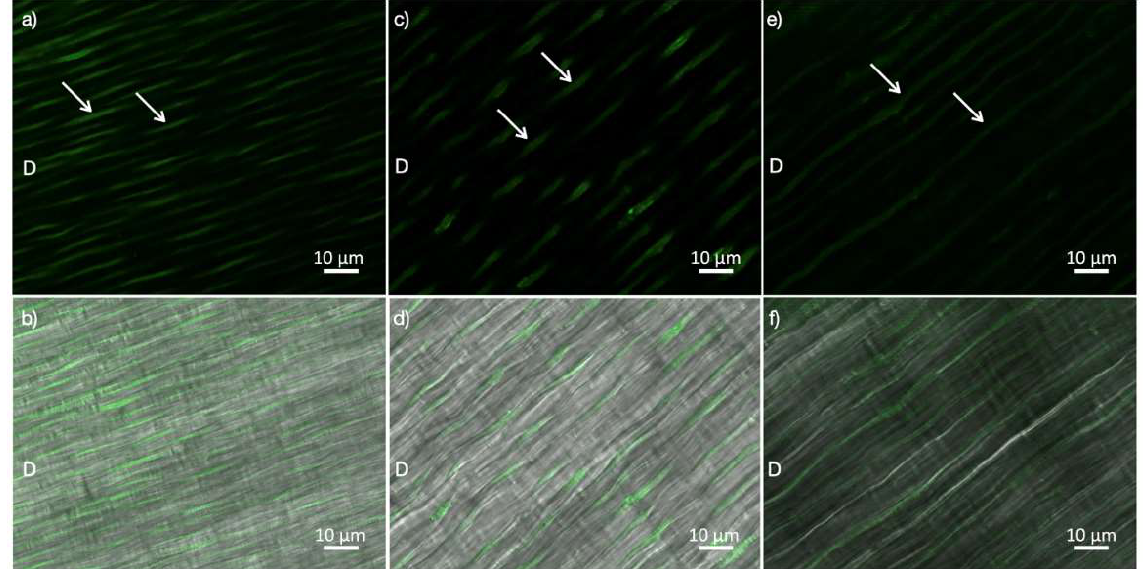
Figure 2. Dentin slices derived from all groups that were incubated with quenched fluorescein-labeled gelatin (D). In-situ zymographic assay showed similar enzymatic activity between the investigated groups. ( a ) Image acquired in the green channel, showing fluorescence (identifying medium level of endogenous enzymatic activity) in dentinal tubules induced with 35% HP treatment. ( b ) Image of 35% HP group, obtained by merging the differential interference contrast (DIC) image and the image acquired in the green channel. ( c ) Image acquired in the green channel, showing fluorescence (identifying medium level of endogenous enzymatic activity) in dentinal tubules induced with 10% CP treatment. ( d ) Image of 10% CP group, obtained by merging the DIC image and the image acquired in the green channel. ( e ) Image acquired in the green channel, showing fluorescence (identifying medium level of endogenous enzymatic activity) in dentinal tubules with no treatment (control group). ( f ) Image of the control group, obtained by merging the DIC image and the image acquired in the green channel. Arrows show enzymatic activity. HP: hydrogen peroxide, CP: carbamide peroxide.